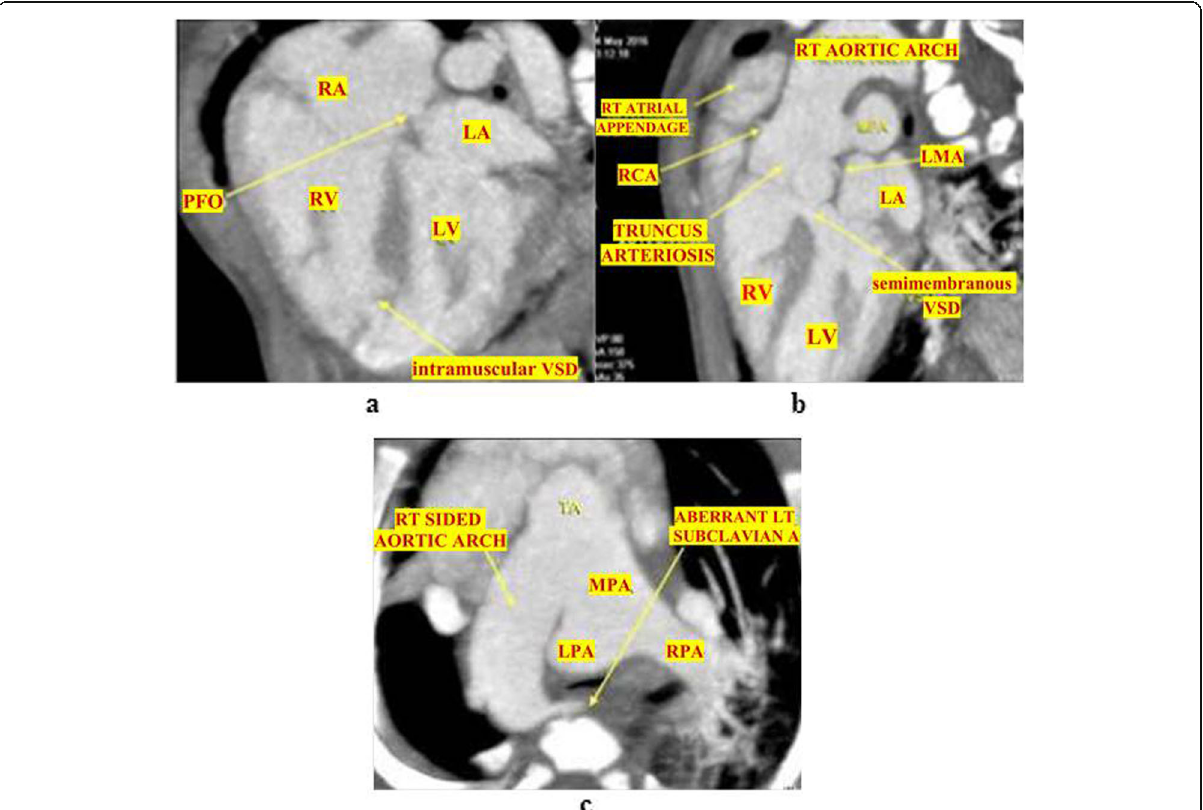
Fig. 2 Three-month-old male patient with poor feeding. ECHO revealed evidence of ASD, conotruncal septal defect, and single trunk overriding IVS and giving rise to aorta and pulmonary artery. ECG-gated multi-slice CT angiography of the heart and great vessels confirmed the presence of ASD and muscular VSD as well as the single trunk (truncus arteriosus) with wide root that is overriding the VSD and supplying the thoracic aorta and the pulmonary artery on oblique sagittal ( a ) and ( b ) MIP images. It also revealed that the aortic arch is right-sided with aberrant left subclavian artery, running posterior to the trachea, and esophagus on reformatted axial image ( c ), which was not detected by ECHO